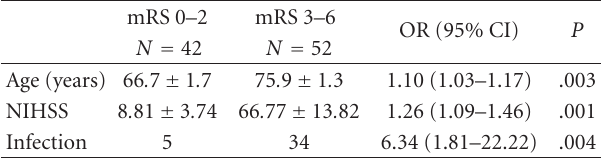
Table 5: Multivariate predictors of poor outcome (mRS 3–6) at 90